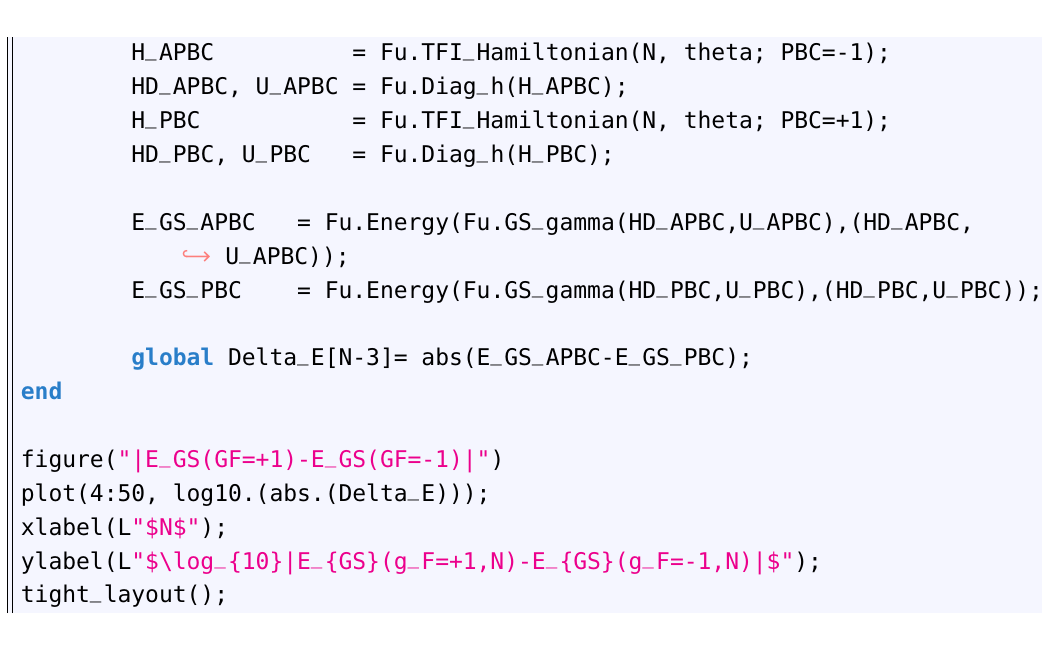
Figure 8: Output of the code 5.2. The three plots represent the analytical and nu- merical values of the free mode energies ε of the Hamiltonian (122) computed with k antiperiodic, periodic, and free boundary conditions. We see that the energies com- puted with F_utilities correspond to the one computed